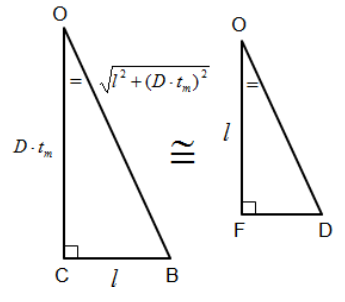
Figure 5. Geometrical similarity of ∆OCB and ∆OFD (refer to Figure